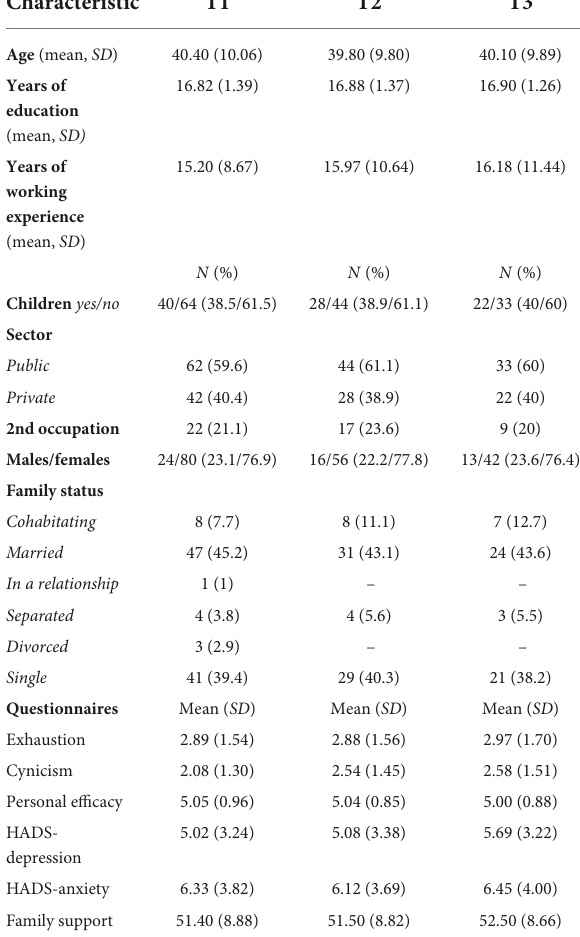
TABLE 1 Demographic characteristics of the participants at T1 ( N = 104), T2 ( N = 72), and T3 ( N =